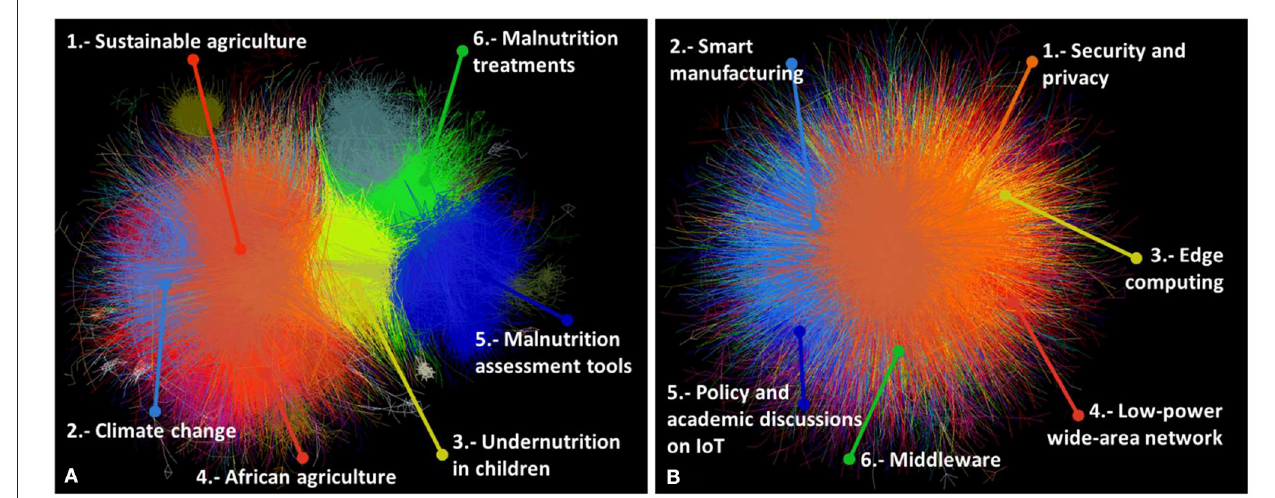
FIGURE 2 | Citation network of (A) food security and (B) IoT research. The top six large clusters are